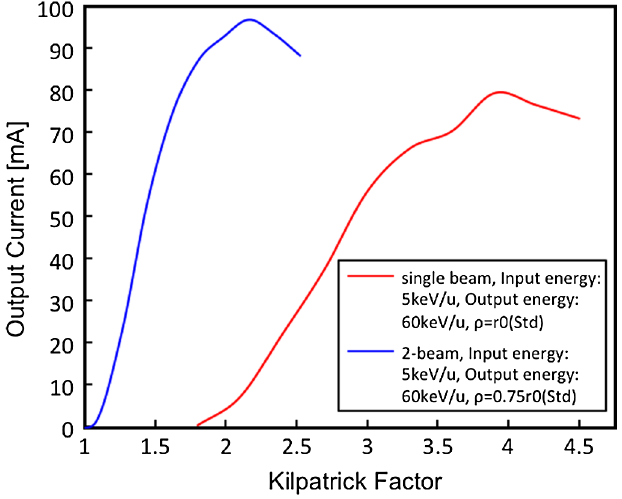
FIG. 15. Output current as a function of the Kilpatrick factor in a single and two-beam RFQ linac. Input current is 120 mA.